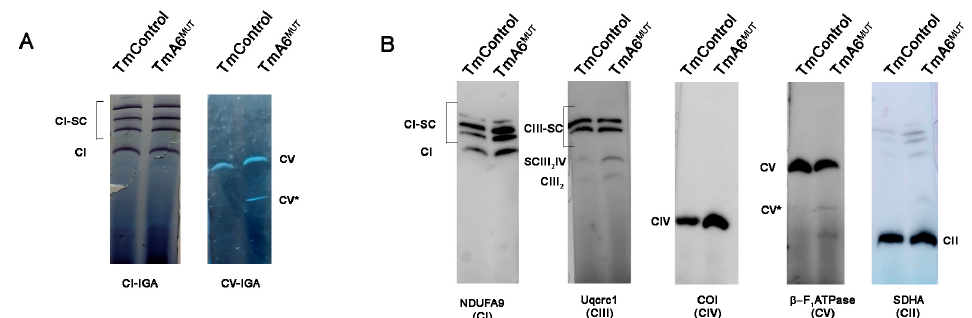
Figure 5. OXPHOS complex and supercomplex assembly analysis: ( A ) pattern of mitochondrial complexes and supercomplexes containing CI (left panel) and CV (right panel) analyzed by BN- PAGE followed by enzymatic IGA of the indicated complexes; and ( B ) immunodetection of the different OXPHOS complexes and supercomplexes in TmControl and TmA6 MUT mitochondria. Antibodies: anti-NDUFA9 for complex I, anti-Uqcrc1 for complex III, anti-Cox1 for complex IV, anti- β - F 1 ATPase for complex V and anti-SDHA for complex II. Notice the higher presence of a band corresponding to CV subcomplexes (CV*) and of low molecular weight antibody-reacting material in mutant mitochondria.